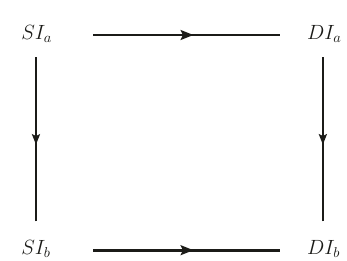
Figure 2 . Transmuting integrands. SI and DI stand for single-cover and double-cover integrands respectively. Subscripts a and b refer to theory- a and theory- b . The normal lines indicate the applying of di(cid:11)erential operators, while the bold lines mean change the single-cover integrand to the double-cover